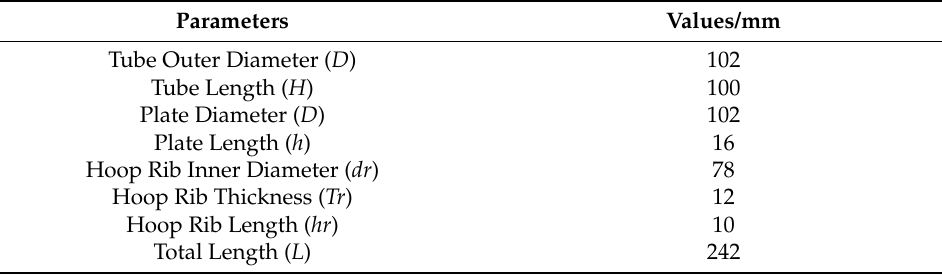
Table 1. Nominal dimensions of bi-segment cylindrical preform, plate, and hoop rib.